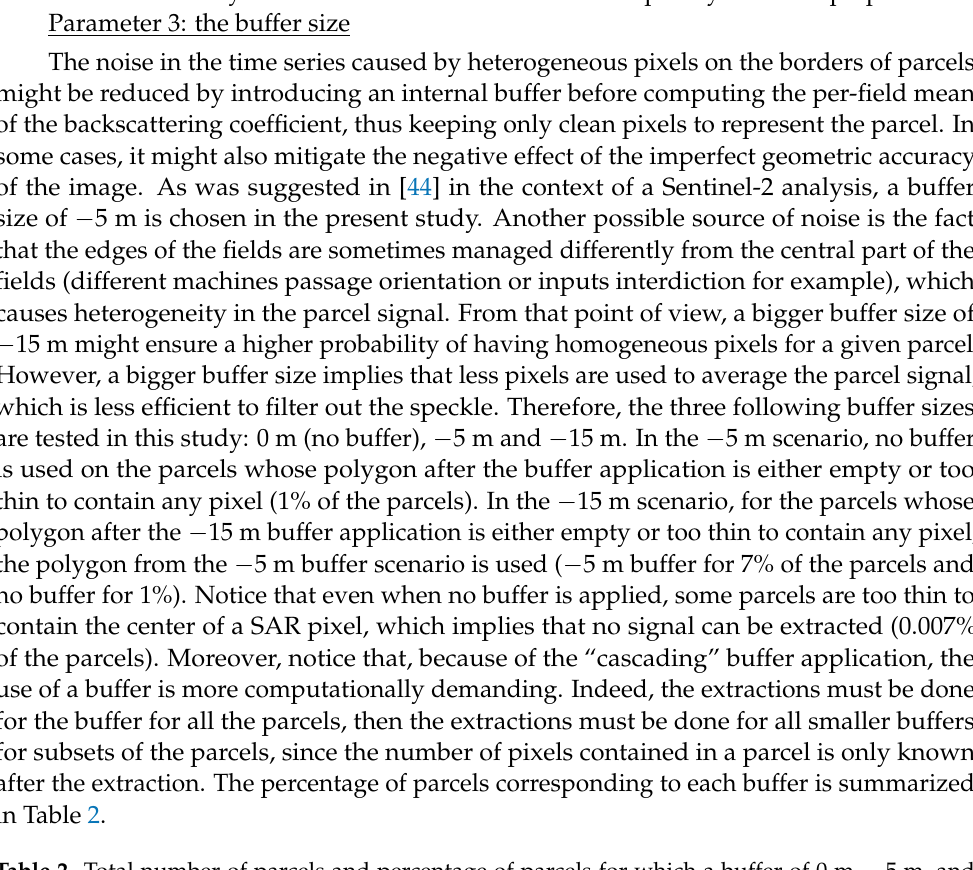
Table 2. Total number of parcels and percentage of parcels for which a buffer of 0 m, − 5 m, and − 15 m is applied for each buffer